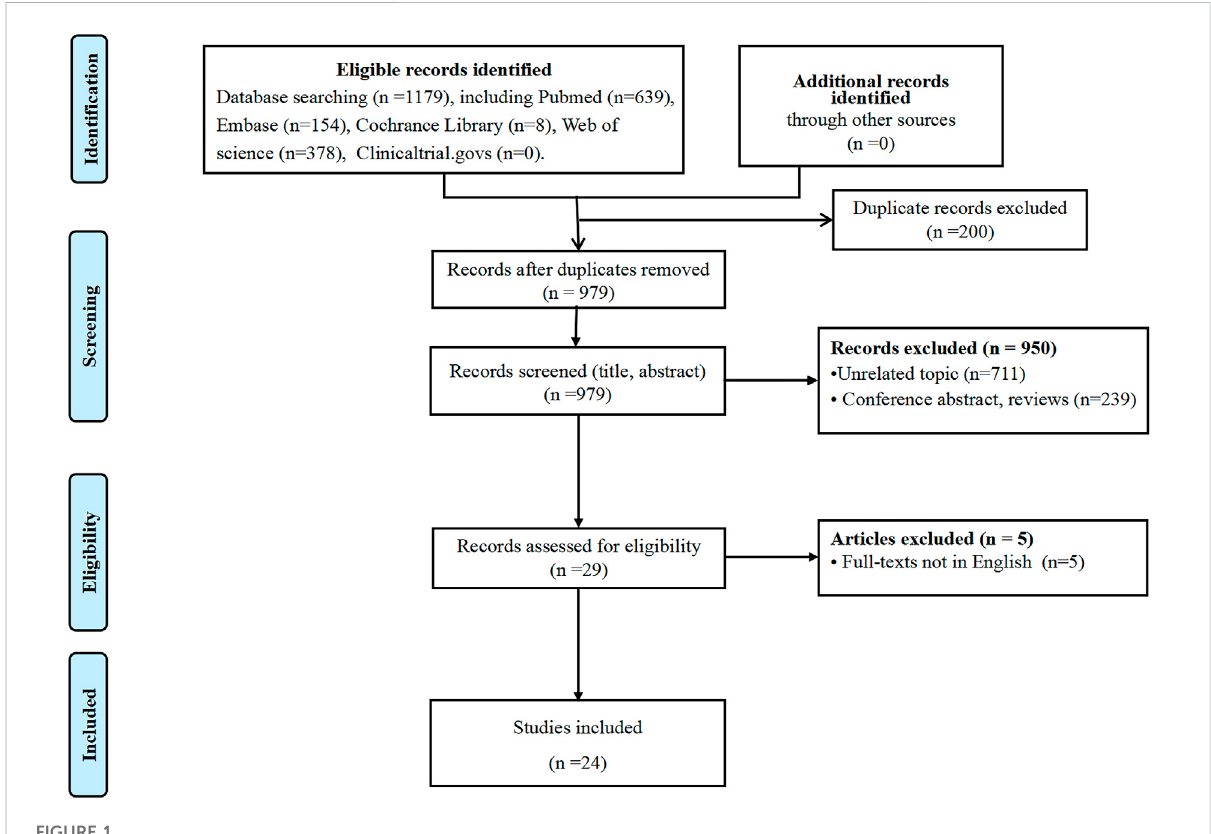
Flow diagram of the search for eligible